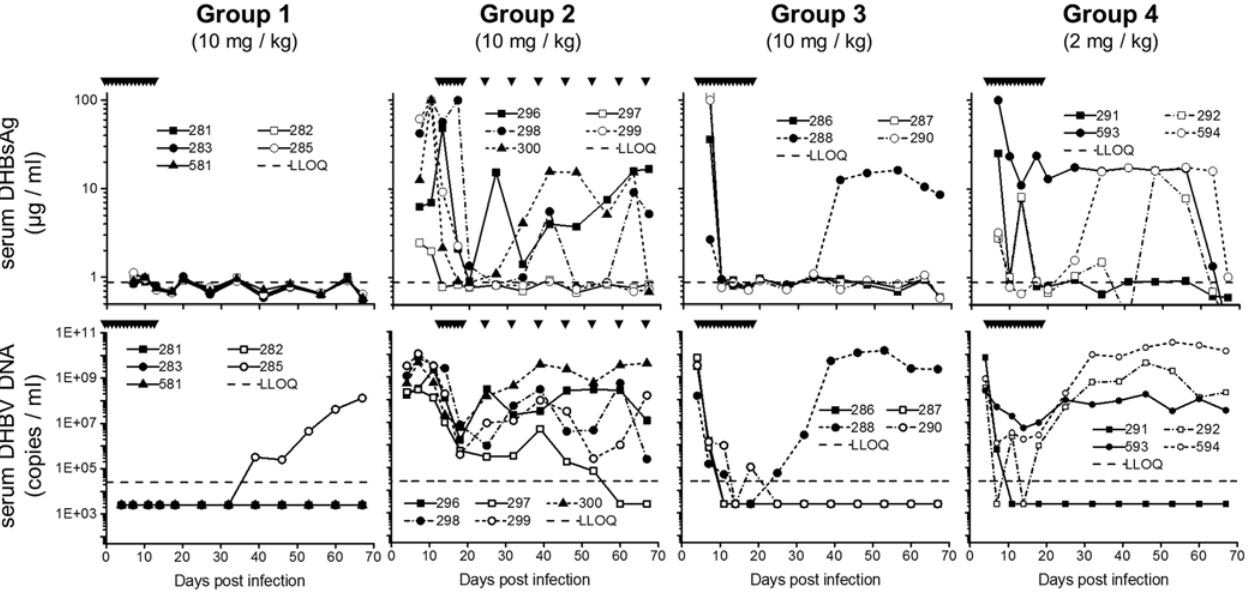
Fig 3. In vivo Experiment 1. Response to various REP 2055 treatment regimens in Groups 1 – 4 . Individual duck data for serum DHBsAg (top row) and serum DHBV DNA (bottom row). Days of REP 2055 treatment are indicated at the top of each graph by inverted triangles (see also Fig 1A). LLOQ for DHBsAg (0.88 μ g/ml) and DHBV DNA (24000 copies/ml) are shown as dashed lines.